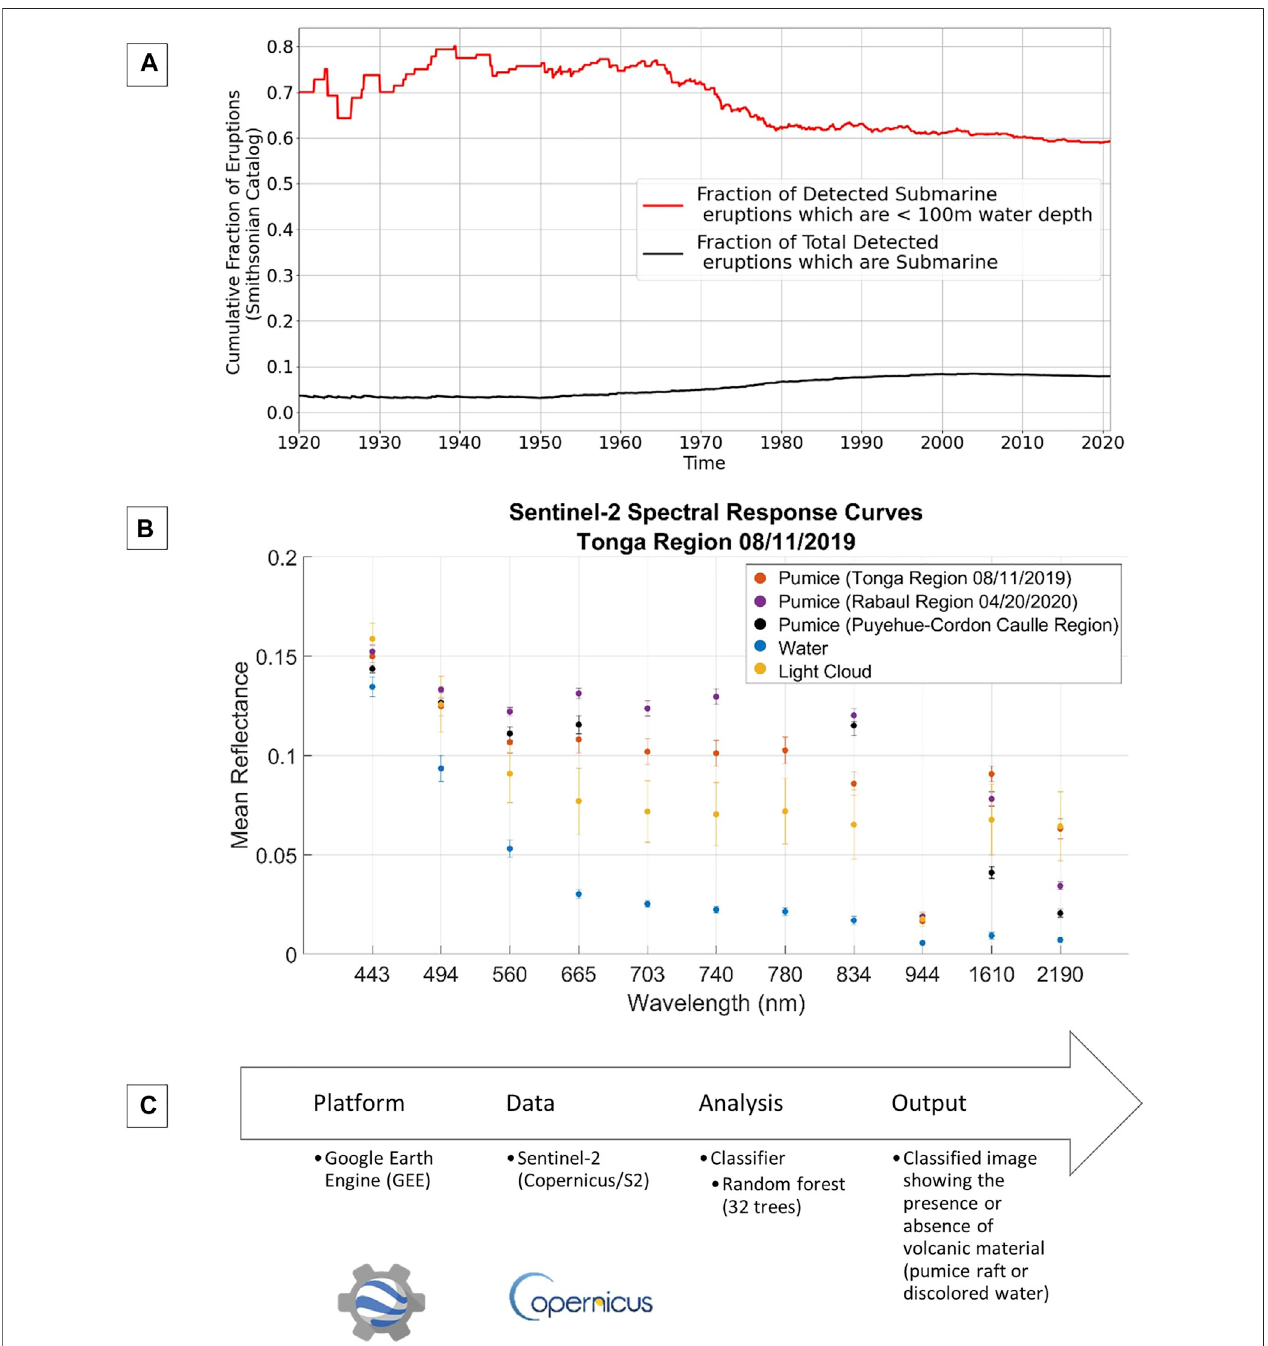
FIGURE 1 | (A) Fraction of all detected submarine eruptions out of total eruptions and fraction of detected shallow submarine eruptions (less than 100 m water depth) out of all detected submarine eruptions (Global Volcanism Program, 2013). Only a small fraction of submarine eruptions are pumice-forming. (B) Mean spectral response curves generated for a Sentinel-2 raft image in the Tonga region (11 August 2019). Error bars are generated from the standard deviation measured for each wavelength.SpectralresponsecurvesforpumicefromtheRabaulregion(20April2020)andalakenearPuyehue-CordónCaullearealsoprovidedforcomparison. For Puyehue-Cordón Caulle, Sentinel-2 imagery was not available, so Landsat 8 imagery was used instead, and mean re fl ectance values were averaged between two dates (19 June 2013 and 5 October 2013). (C) Schematic of work fl ow used in this study.